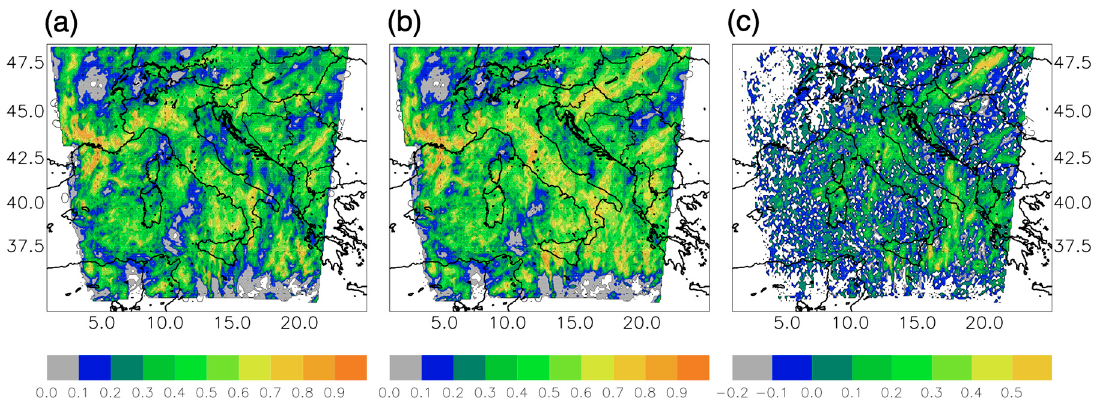
Figure 2. Mean precipitation over the month of November 2019 for ( a ) CTRL forecast, ( b ) LIGHT Figure 1. n Equation (2), y i is the precipitation 3 h forecast, o i is the corresponding observation given by IMERG dataset, N is the total number of data for each grid point ( N = 232), and 𝑦(cid:3364) and 𝑜̅ are, respectively, the forecast and observed averages for each grid point. The correlation results are shown in Figure 3.